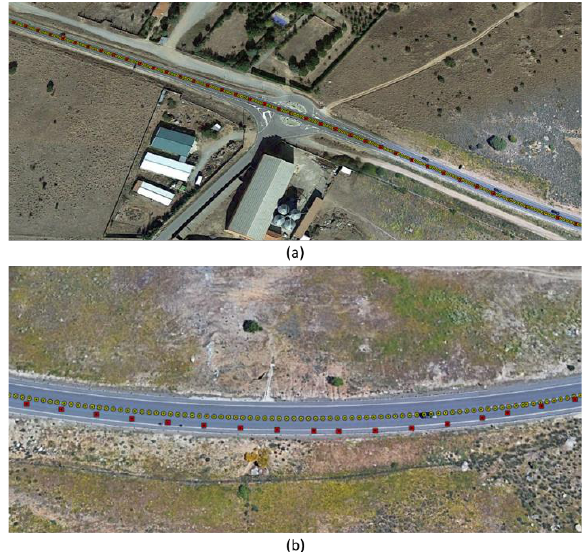
Figure 10. Visualization of the results in Google Earth. (a) Alignment computed by the proposed method (yellow) and ground truth data (red) are sampled over the satellite image. (b) A source of large errors are discrepancies between the ground truth data and the actual road